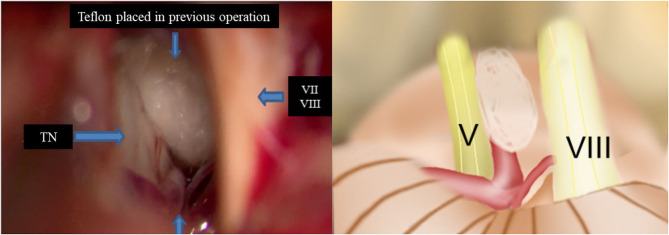
Intraoperative findings of redo MVD showing offender vessel omission in the previous operation. (TN, trigeminal nerve; VII, facial nerve; VIII, vestibulocochlear nerve).